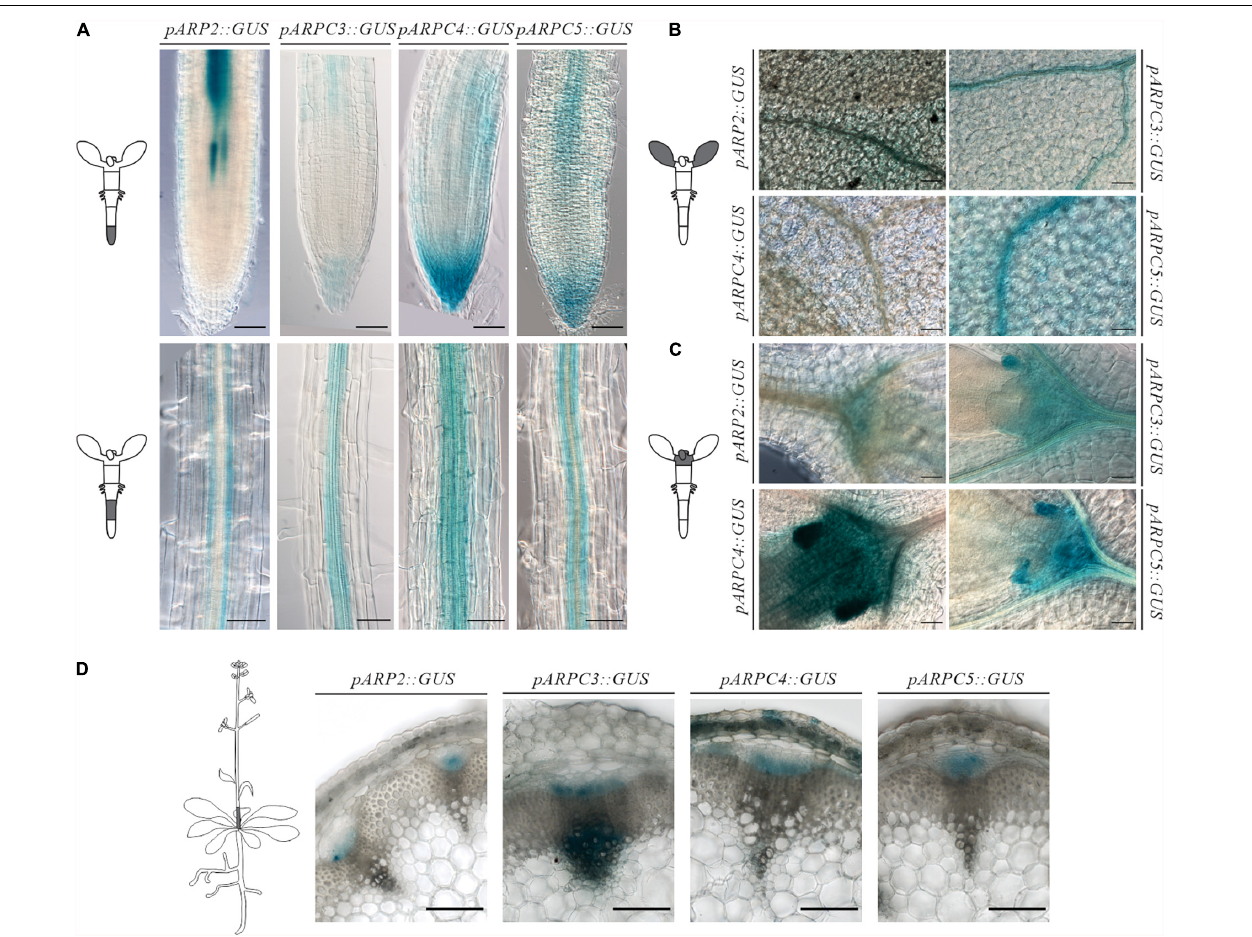
FIGURE 1 | Spatiotemporal expression pattern of individual ARP2/3 complex subunits genes (ARP2, ARPC3, ARPC4 and ARPC5) as revealed by promoter-GUS activity. Analysis of GUS histochemical staining was done in Arabidopsis thaliana 7-day-old seedlings roots (A) , cotyledons (B) , shoot apical meristem (C) . Reporter signal was present at the provasculature, columella and quiescent center, pavement cells, mesophyll, stomata and shoot apical meristem (D) GUS production was tested in transverse sections at the base of six-week-old plants showing promoter activity in vascular bundles. Scale bar = 100 µ